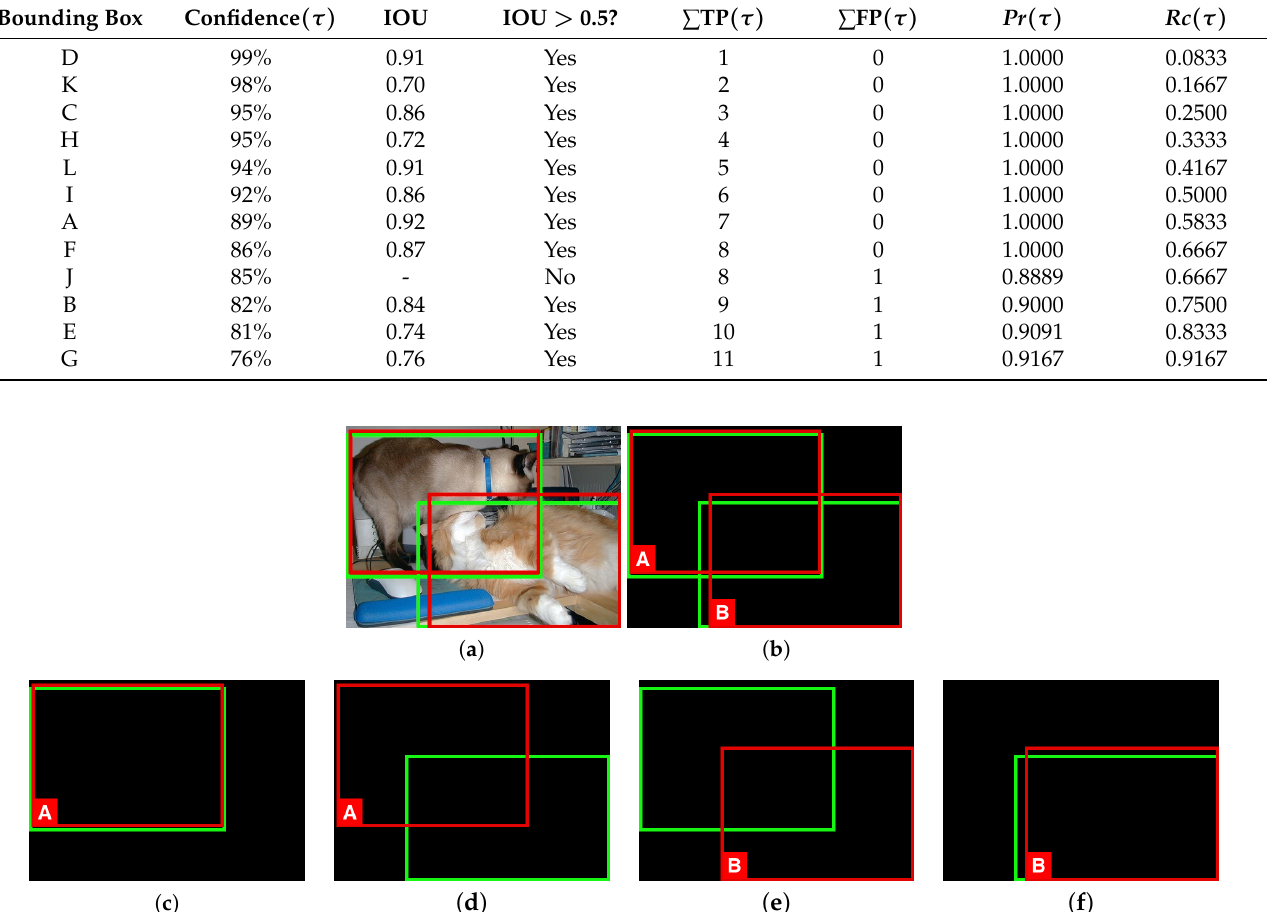
Table 3. Precision and recall values for detections in Figure 3, that contain a total of 12 ground truths, considering an IOU threshold t = 0.5.